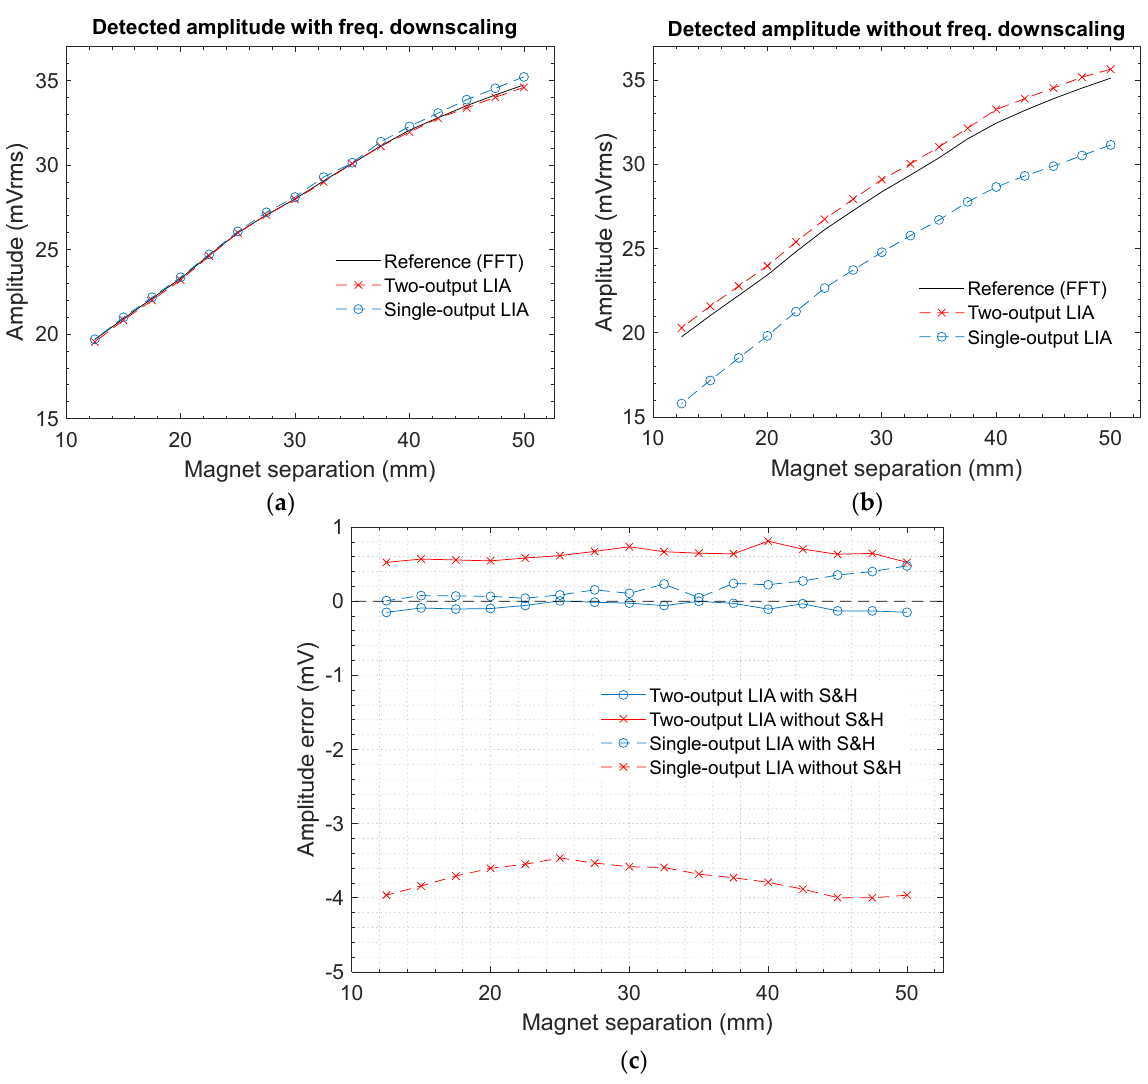
Figure 9. Amplitude measurements of the LIAs compared with the reference value provided by the FFT function of the digital oscilloscope, versus separation between GMI sensor and magnet: ( a ) amplitude detected by the proposed LIAs using SH blocks for frequency downscaling; ( b ) amplitude detected by the conventional LIAs without frequency downscaling; and ( c ) amplitude error for both LIA architectures with and without frequency downscaling.